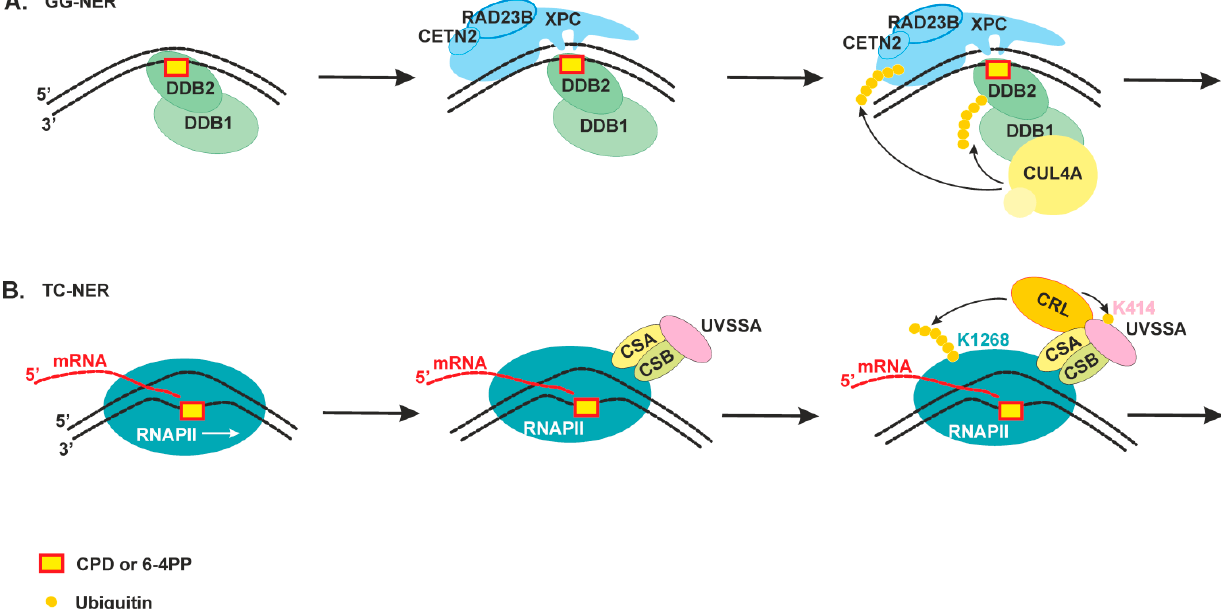
Figure 2. An overview of the damage recognition step of nucleotide excision repair (NER). ( A ) Global genome NER (GG-NER) can search for damage anywhere in the genome throughout the cell cycle. The UV-DDB protein recognizes CPD or 6-4PP, directly binds to it through its DDB2 subunit, and facilitates efficient recognition of the lesion by the XPC–RAD23B–CETN2 complex. The DDB1 subunit is also a connector protein for ubiquitin ligase CUL4, which ubiquitinates DDB2 and XPC [33]. ( B ) Transcription-coupled NER (TC-NER) is responsible for accelerated repair of lesions in the template DNA strand of actively transcribed genes only. The CSB protein and then proteins CSA and UVSSA bind to DNA damage stalled RNAPII. CSB and CSA associate with CRL ubiquitin ligase and contribute to the ubiquitination of the RNAPII RPB1 subunit at K1268. This ubiquitination stimulates the association of TFIIH with the stalled RNAPII through a transfer mechanism that also involves UVSSA-K414 ubiquitination [9,35].